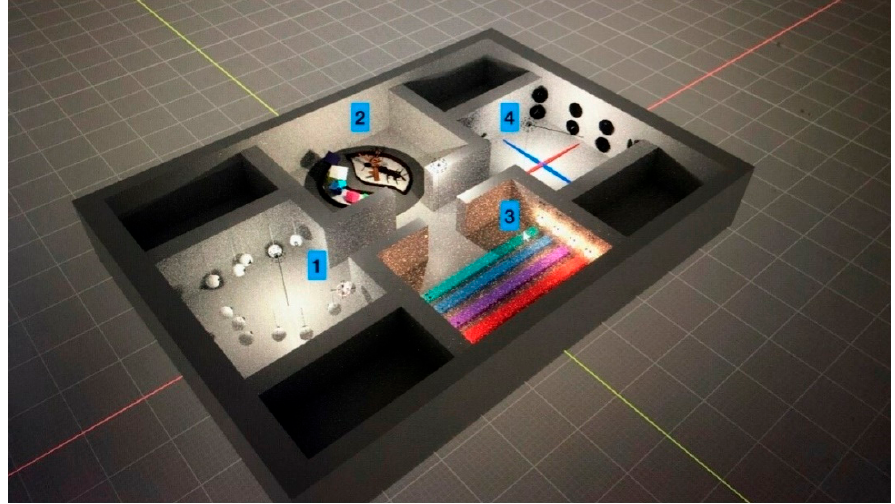
Figure 4. Spatial view of the VR comprehensive rehabilitation rooms (VRCRR).